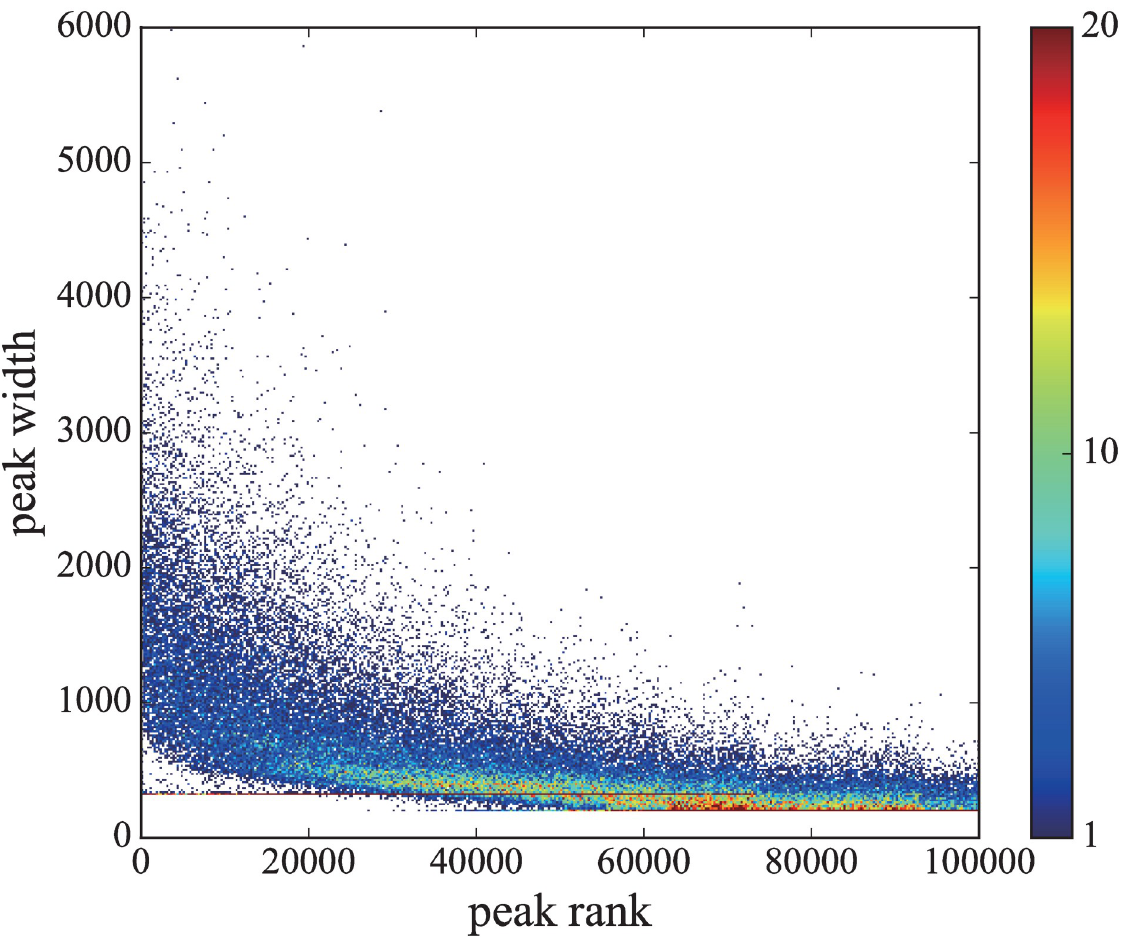
Fig 2. The statistics of peak width. Distribution of peak width ( β result of CD4 + T cells with peak calling parameter p G = 10 − 2 . The bin size is 400 × 400. The color code indicates the number of data in each